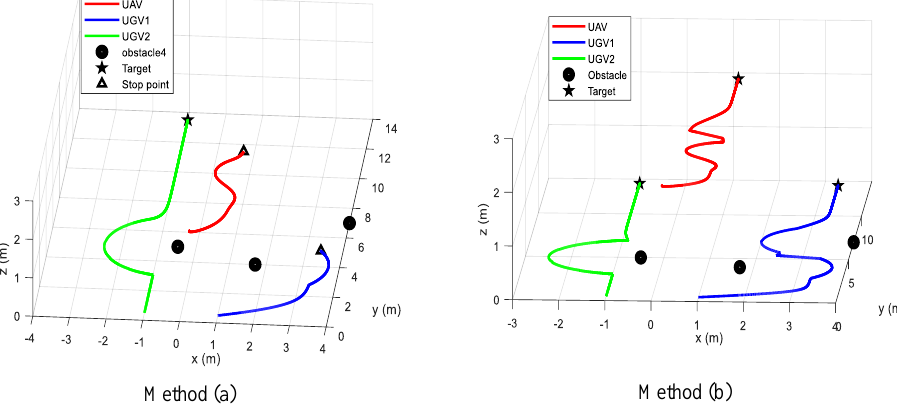
Figure 3. The figure show that the trajectory of method (a) and method (b).